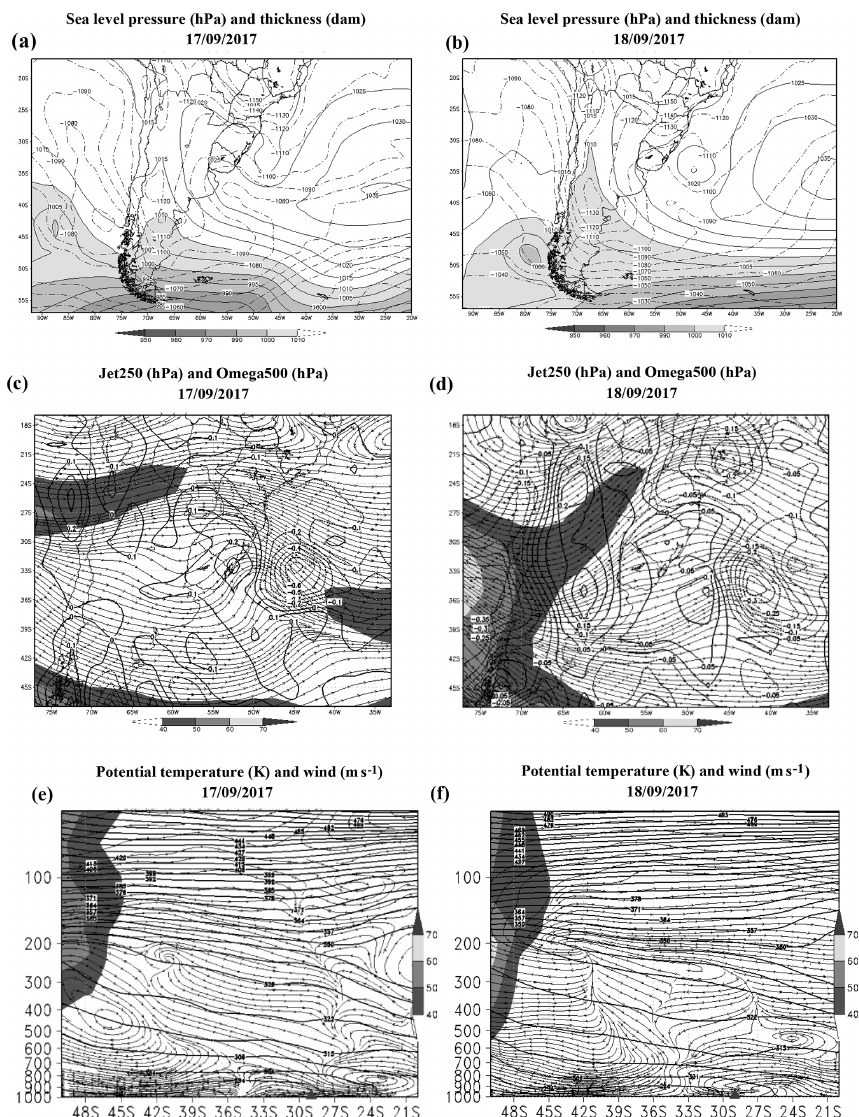
Figure 3. Pressure fields at medium sea level, horizontal cut of the atmosphere, and vertical cut between 1000 and 50hPa for ( a , c , e ) 17 September 2017 and ( b , d , f ) 18 September 2017. The red symbol indicates the location of the SSO